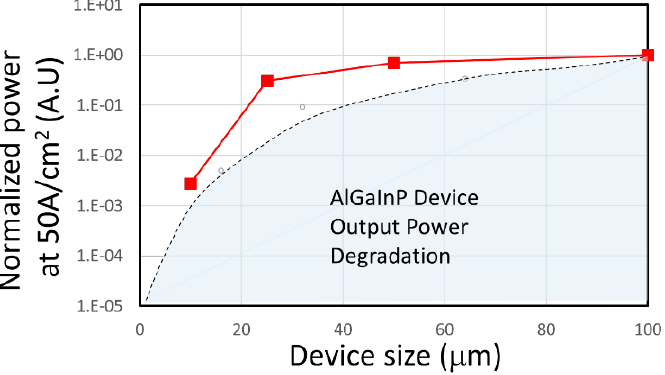
Figure 9. The normalized output power at 50 A/cm 2 for QD-coated micro-LEDs and generic AlGaInP micro-LEDs (passivated by PECVD dielectric layers). The QD LEDs show clear superiority before reaching 25 µ m. The degradation range in the shadowed area was estimated by various references [5,17,27,28].